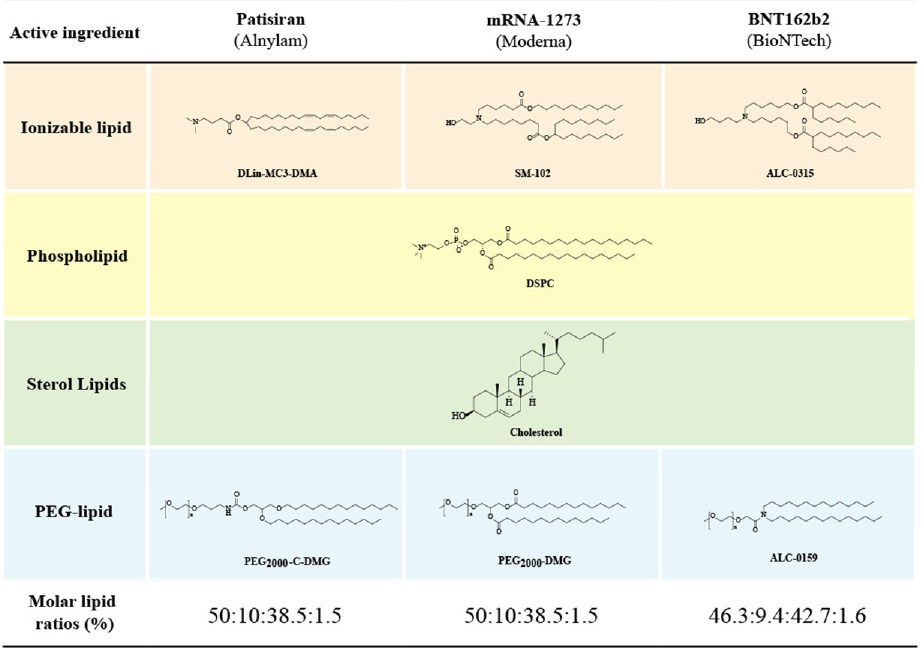
Figure 1. Structure and molar ratio of the component lipids in the three clinical applications of LNPs. Reprinted with permission from Ref. [61]. Copyright © 2021 The Japanese Society for the Study of Xenobiotics. Published by Elsevier Ltd.